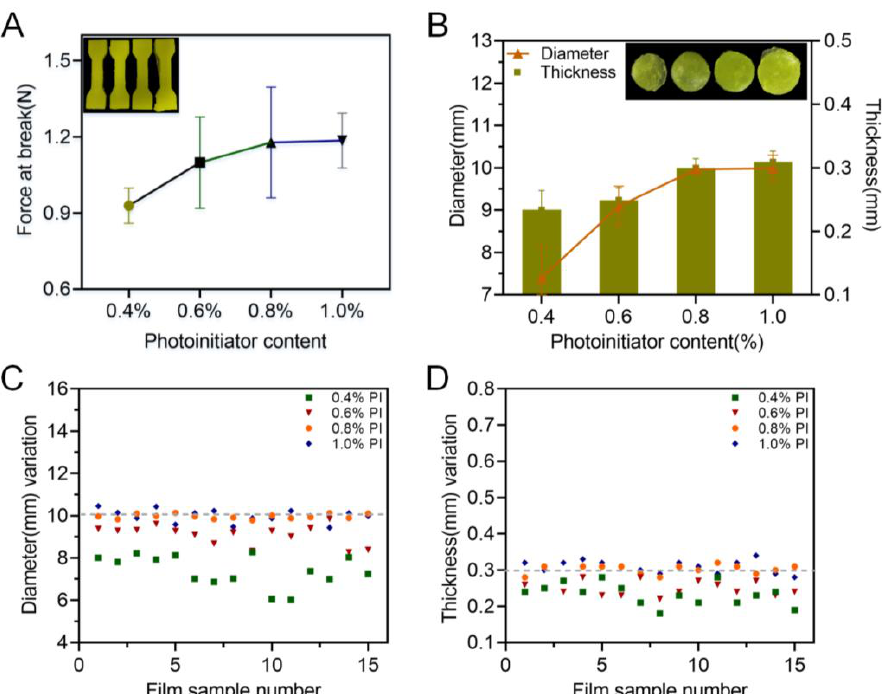
Figure 4. Effect of the photoinitiator on the printability: ( A ) force at break of specimen samples (n = 6); ( B ) thickness and diameter of 3D-printed oral film samples (n = 15); ( C ) diameter variations and ( D ) thickness variations of 3D-printed oral film samples.